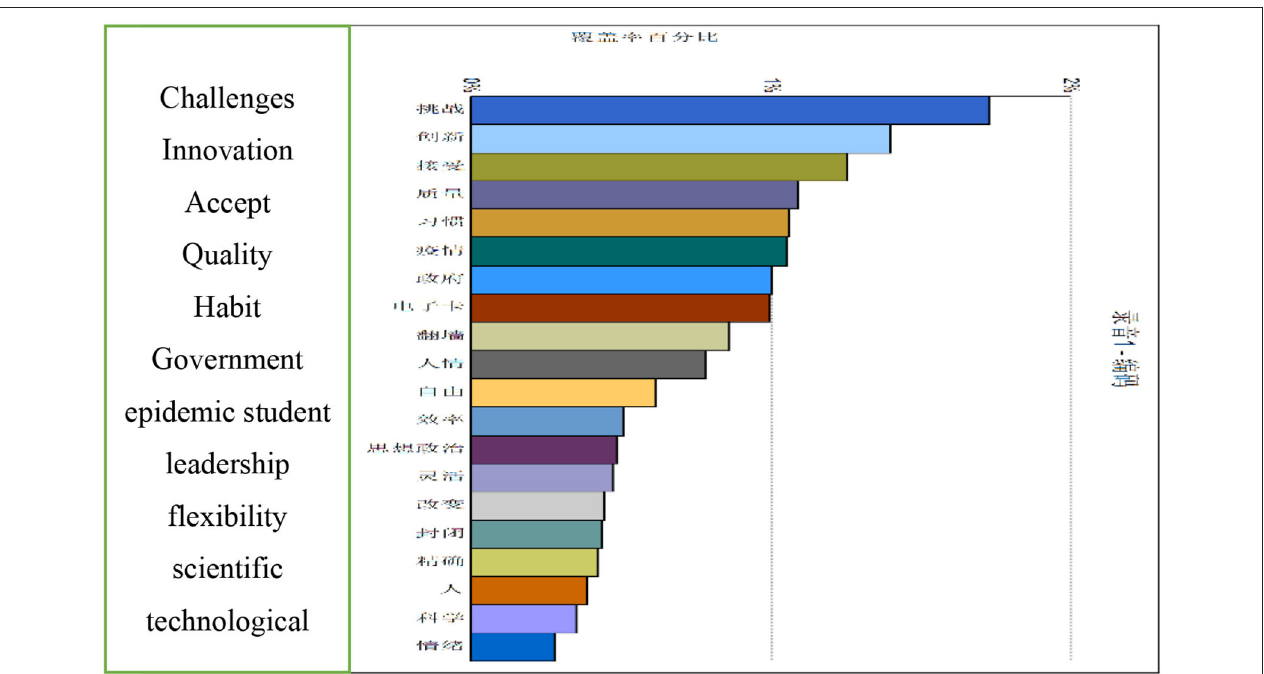
FIGURE 1 | The percentage of the